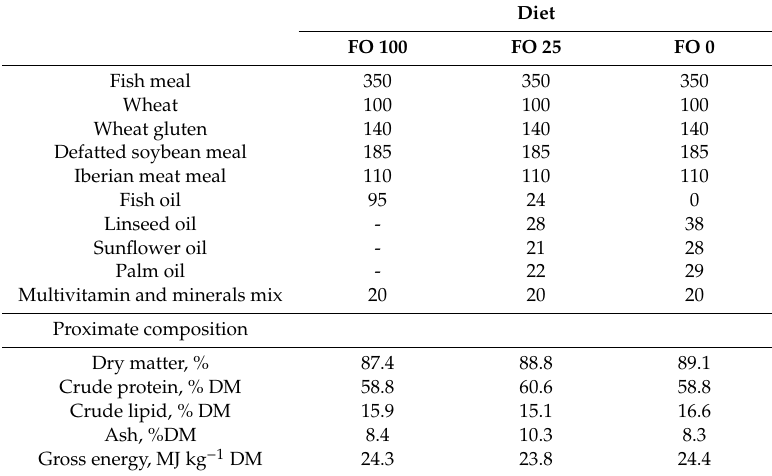
Table 1. Ingredients (g kg − 1 as fed) and proximate composition (% dry matter; DM) of the experimental